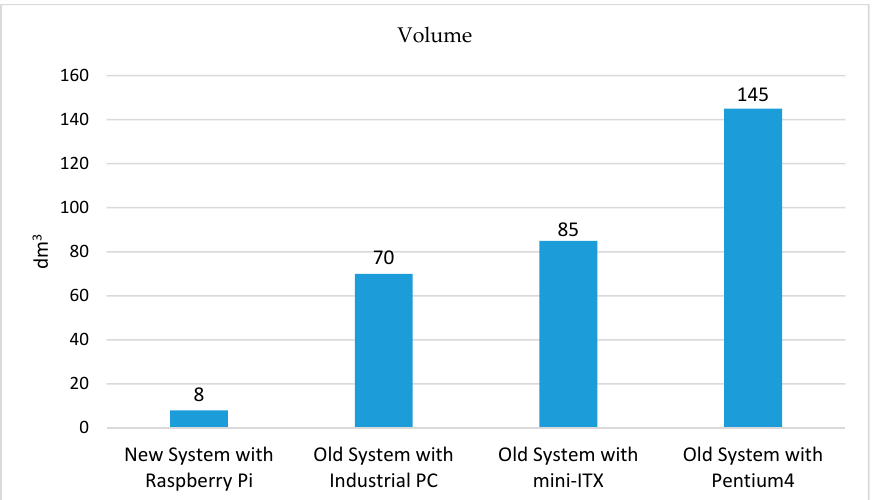
Figure 11. Dimensional comparison between older probes and the new one.